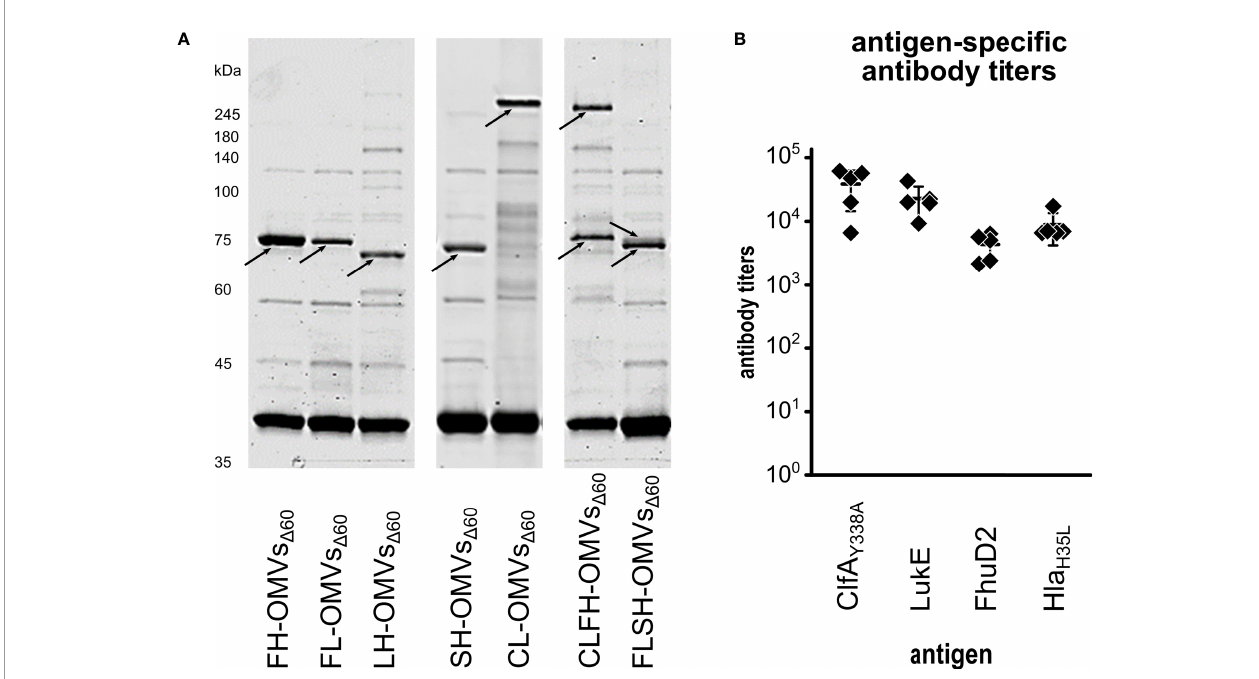
FIGURE 4 | Expression of chimeras in OMVs D 60 . (A) E. coli BL21(DE3) D 60 was transformed with plasmids expressing the following chimeras: FhuD2-Hla H35L , FhuD2- LukE, LukE-Hla H35L , SpA KKAA -Hla H35L and ClfA Y338A -LukE. One recombinant clone from each transformation was inoculated in liquid culture and the corresponding OMVs, named FH-OMVs D 60 , FL-OMVs D 60 , LH-OMVs D 60 , SH-OMVs D 60 and CL-OMVs D 60 , respectively, were puri fi ed from each culture supernatants. Puri fi ed OMVs were analyzed by SDS-PAGE (10 m g total OMV proteins) (left panel). The right panel reports the SDS-PAGE analysis of OMVs from E. coli BL21(DE3) D 60 co-transformed with plasmids expressing either ClfA Y338A -LukE and FhuD2-Hla H35L (CLFH-OMVs D 60 ) or FhuD2-LukE and SpA KKAA -Hla H35L (FLSH-OMVs D 60 ) using pET21b(+) and pACYC, respectively (see Materials and Methods for details). (B) A group of fi ve mice were immunized three times two weeks apart with CLFH-OMVs D 60 . After two weeks from the last immunization sera were collected and pooled and the ELISA titers were measured coating the plates with recombinant